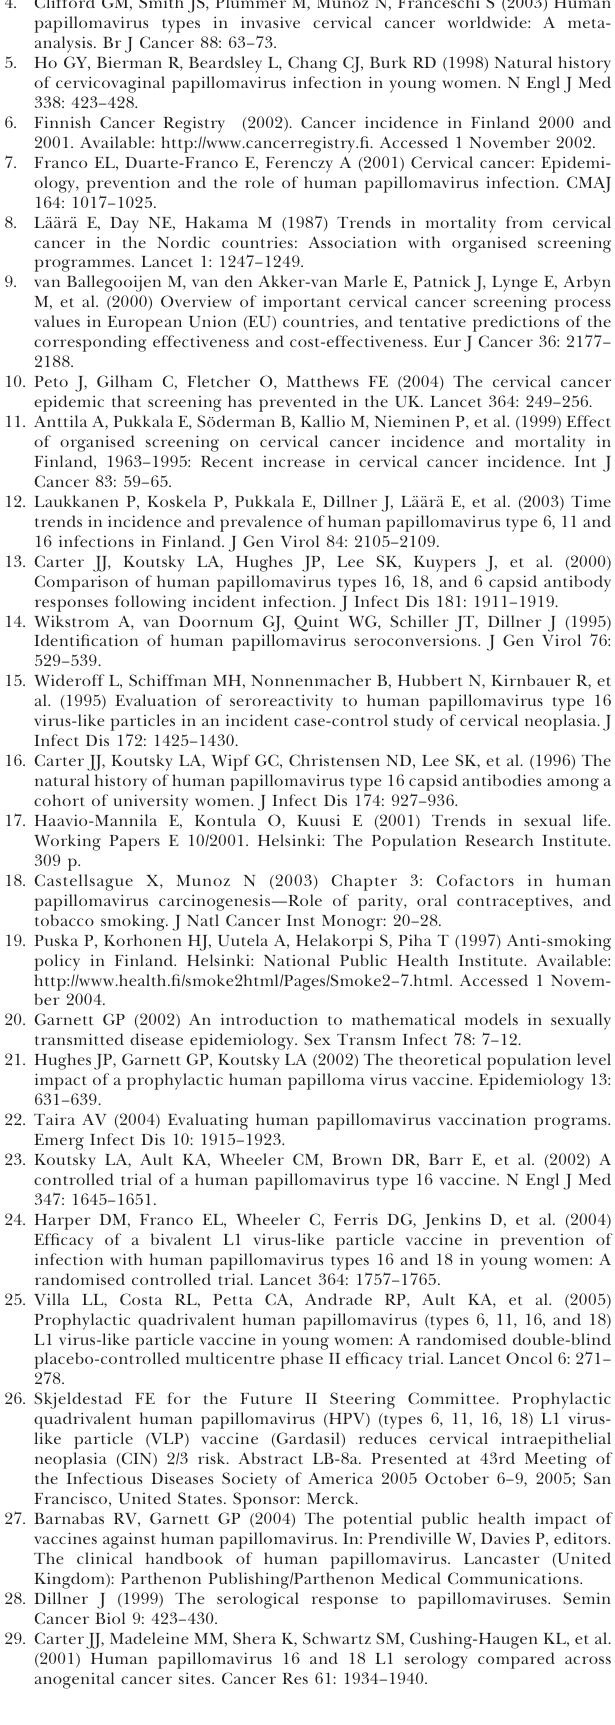
Figure S3. Observed HPV 16 Age-Specific Invasive Cervical Cancer Incidence versus Model Prediction without Screening and with